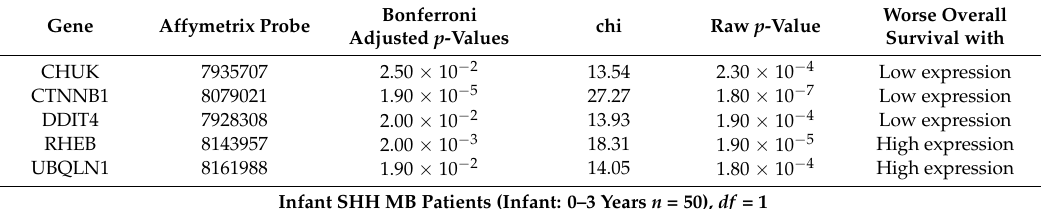
Table 6. Overall survival of SHH MB patients (GEO ID: gse85217); df , degrees of freedom. Infant and Pediatric SHH MB Patients (Infant: 0–3 Years n = 50, Pediatric: 4–10 Years n = 45; 10–17 Years n = 26; Total n = 121), df = 1, chi, chi Squared Test.